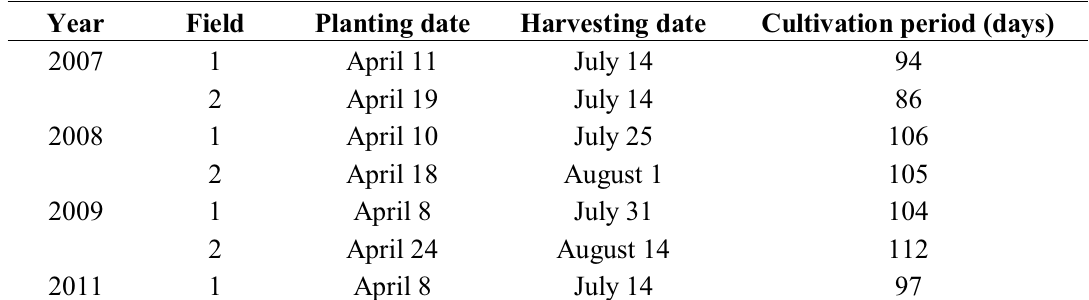
Table 1. Planting and harvesting dates and cultivation on fields involved in